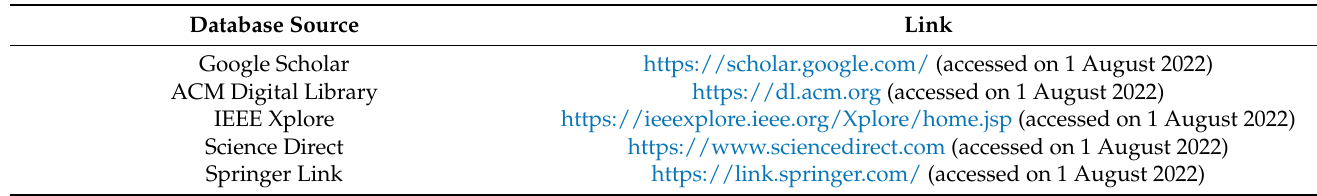
Table 2. List of used online electronic